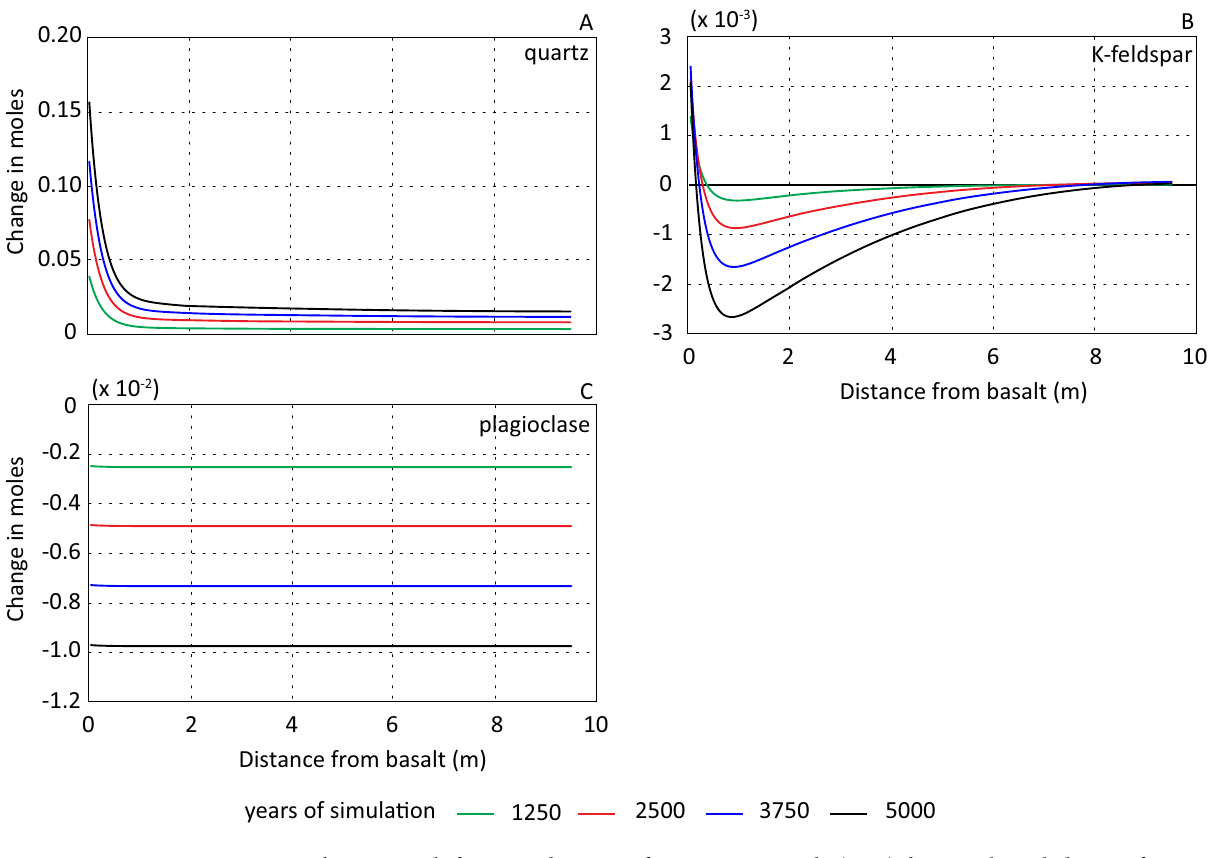
Figure 6. Change in mole from initial amounts for primary minerals. ( A – C ) show results with distance from basalt-sandstone interface in meter after 1250 (green), 2500 (red) 3750 (blue) and 5000 (black) years for scenario 2.